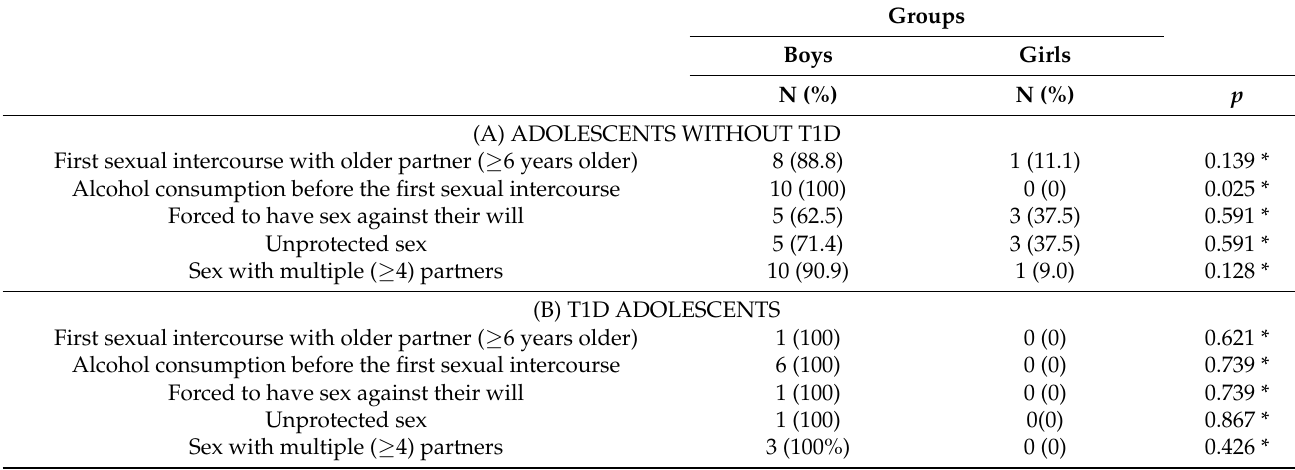
Table 3. Analysis of risky behaviors by gender.